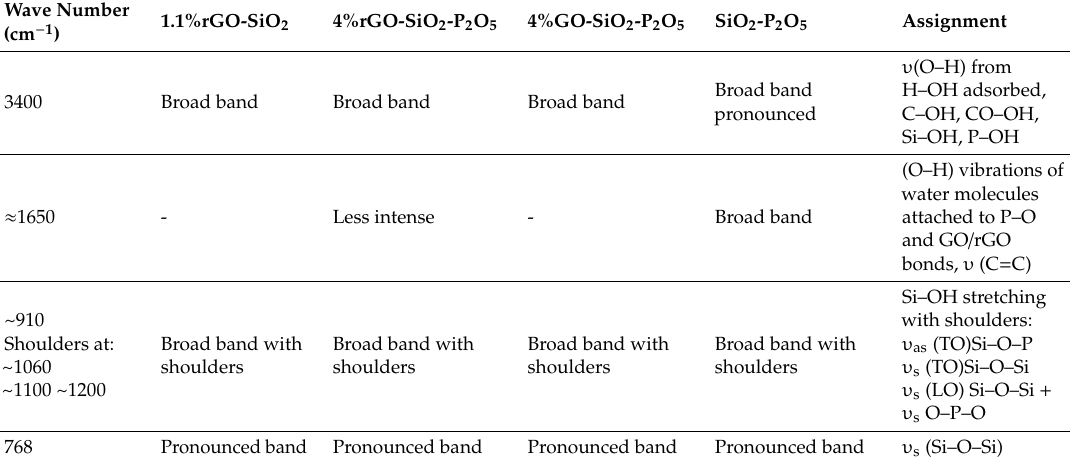
Figure 1. The relationship between neighboring sliced gears.